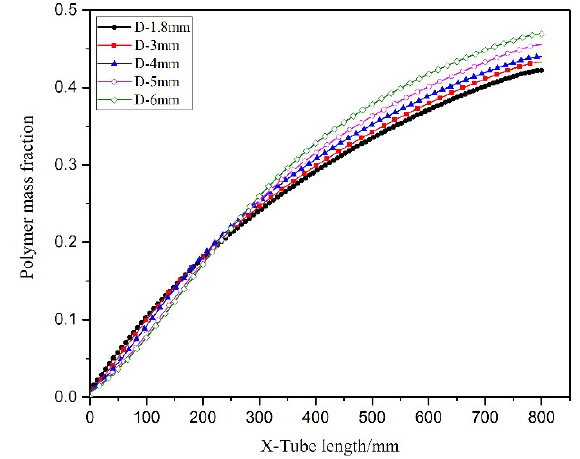
Figure 19. Polymer curves of conversion rate in microreactors with different tube diameters.